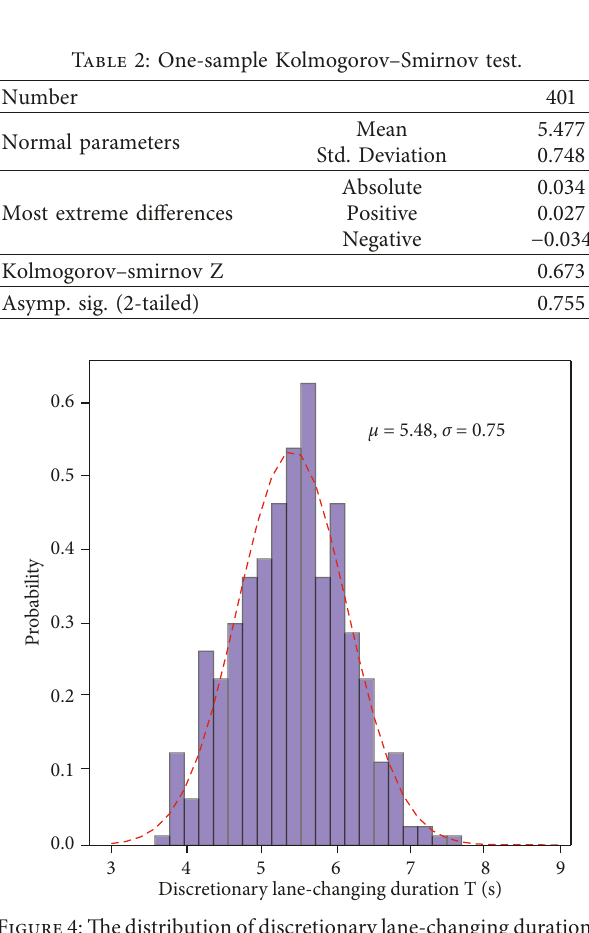
Figure 4: The distribution of discretionary lane-changing